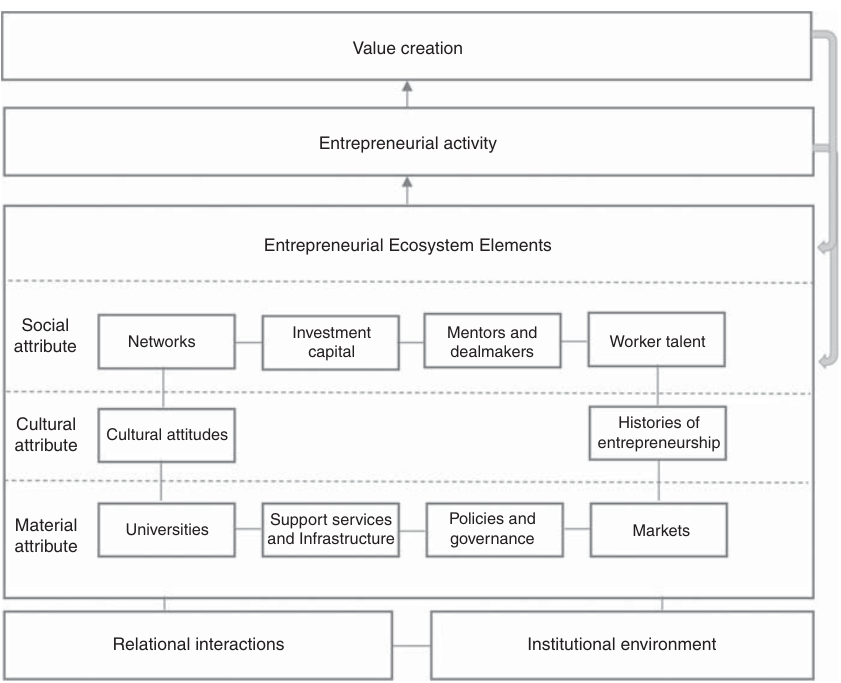
Figure 1. Composition